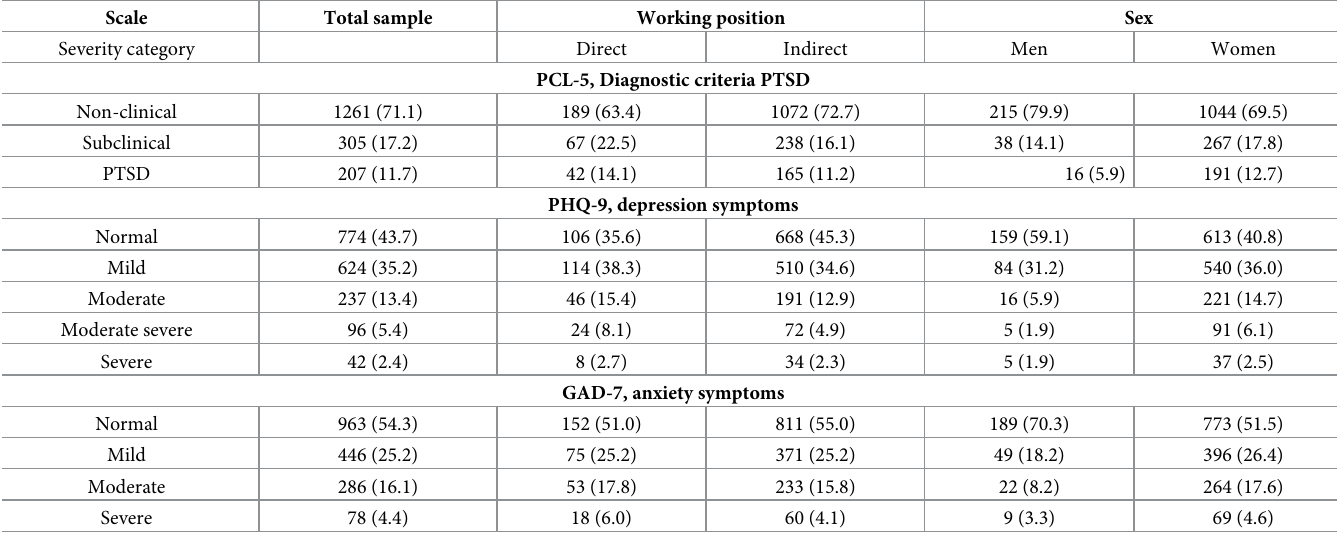
Table 2. Cut off scores on PTSD symptoms, anxiety and depression.